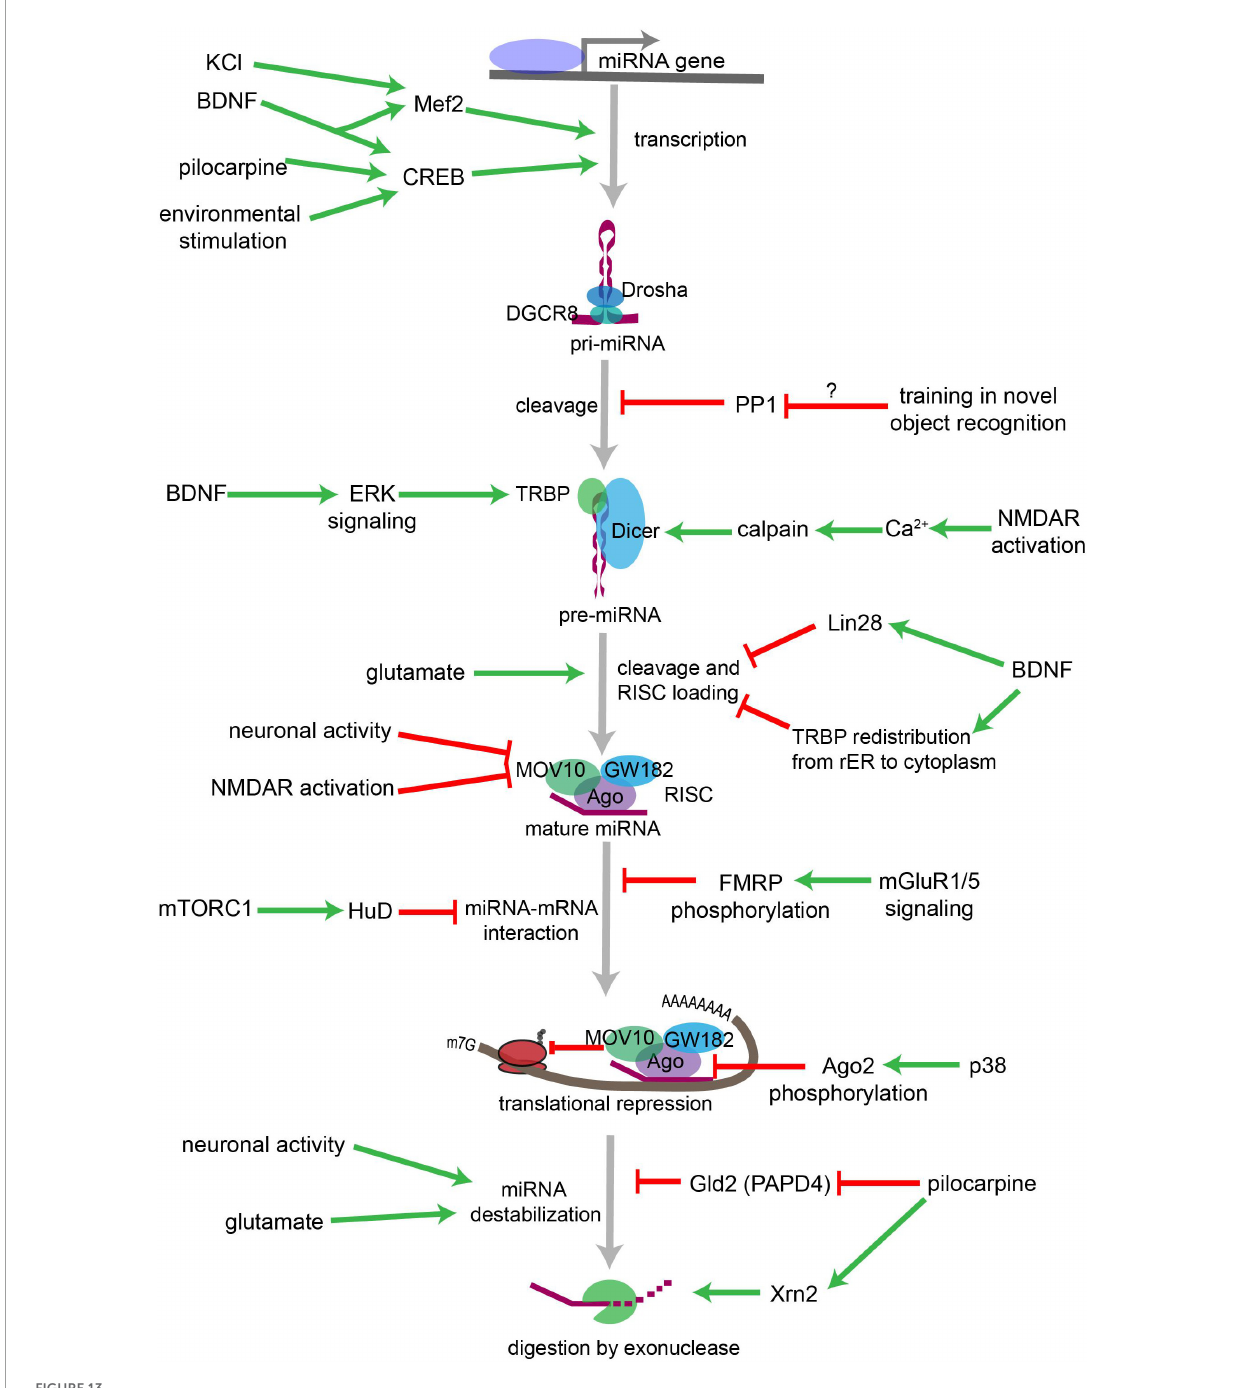
FIGURE13 Overview of neuronal signaling events that influence miRNA biogenesis, activity, and degradation. Each step within the miRNA biogenesis pathway may be stimulated (green arrow) or inhibited (red bar) by intra- and extracellular signaling events. Pri-miRNA levels increase when BDNF or other signals activate transcription factors that stimulate the transcription of miRNA-encoding genes. Pri-miRNA cleavage by the Microprocessor is influenced by the activity of proteins, such as PP1 which inhibits Microprocessor activity. Pre-miRNA cleavage by Dicer is increased in response to glutamate, BDNF signaling, or NMDA receptor activation. BDNF can also inhibit Dicer’s ability to cleave some pre-miRNAs by inducing Lin28 binding to the pre-miRNA terminal loop or by promoting TRBP redistribution and dissociation from Dicer. Neuronal activity and NMDA receptor activation inhibit RISC activity by promoting the degradation of the RISC component Mov10. miRNA interactions with target mRNAs are also influenced by RNA binding proteins such as FMRP or HuD neuron-specific HuD and HuB are subject to adenosine-to-inosine RNA editing at five editing sites each (Enstero et al., 2010), which are regulated by mGluRs (GRMs) and mTORC1 signaling, respectively. P38-induced phosphorylation of Ago2 stimulates mRNA translation by causing the RISC to release its bound miRNA. miRNAs may also be destabilized by increases in neuronal activity, by glutamatergic signaling, or by pilocarpine-induced inhibition of the miRNA stabilizing protein Gld2. Pilocarpine may also stimulate miRNA degradation by increasing expression of the exonuclease Xrn2. Figure from Thomas et al. (2018), obtained under a creative commons license 3 and